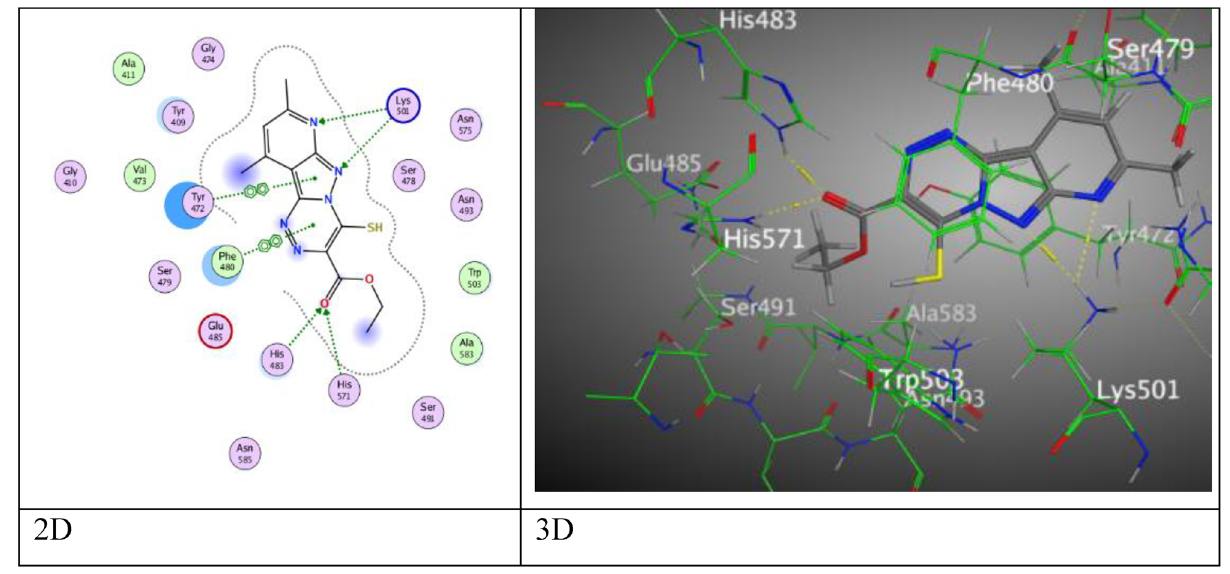
Figure 10. The binding interactions of compound 5a with active sites of (PDB ID: 5IVE).